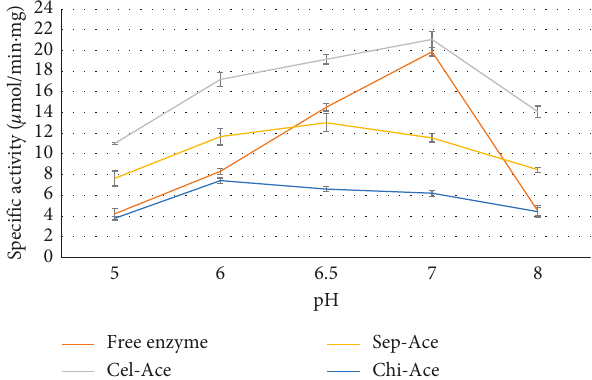
Figure 4: Specific hydrolytic activity of acetone-immobilized samples with varying temperatures (pH 7.0 and [S] (cid:31)